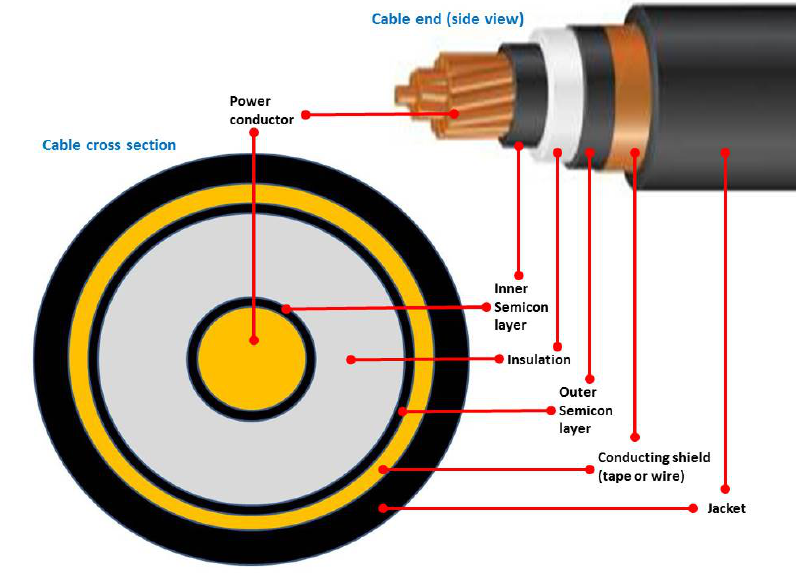
Figure 1. Cable geometry depicting different